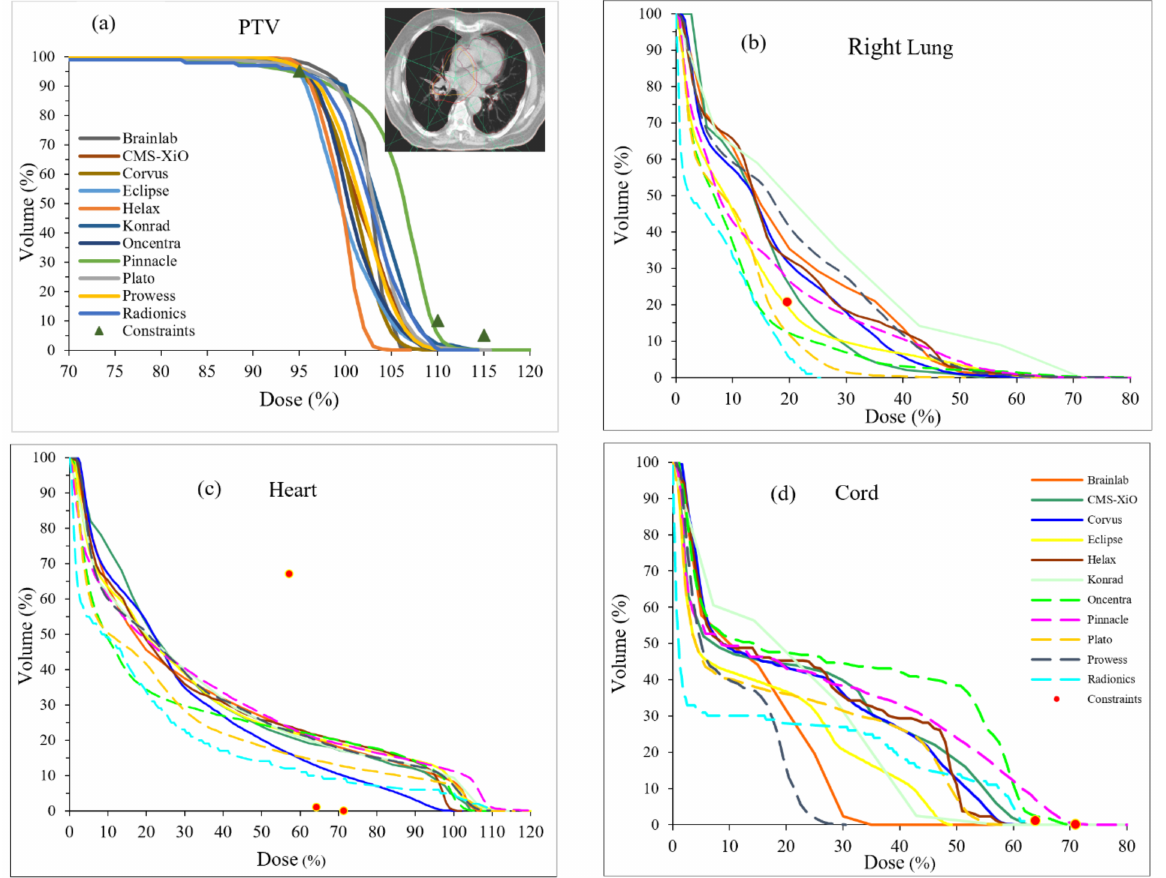
Figure 2. ( a ) Dose–volume histogram of a lung patient from various treatment planning systems. The inset in ( a ) shows the axial CT data of the patient which were sent to every institution. ( b ) Rt lung, ( c ) heart, and ( d ) spinal cord. Please note the variability in dose calculation among eleven systems. Please note that the symbols represent the dose–volume constraints sent to institutions and are required to